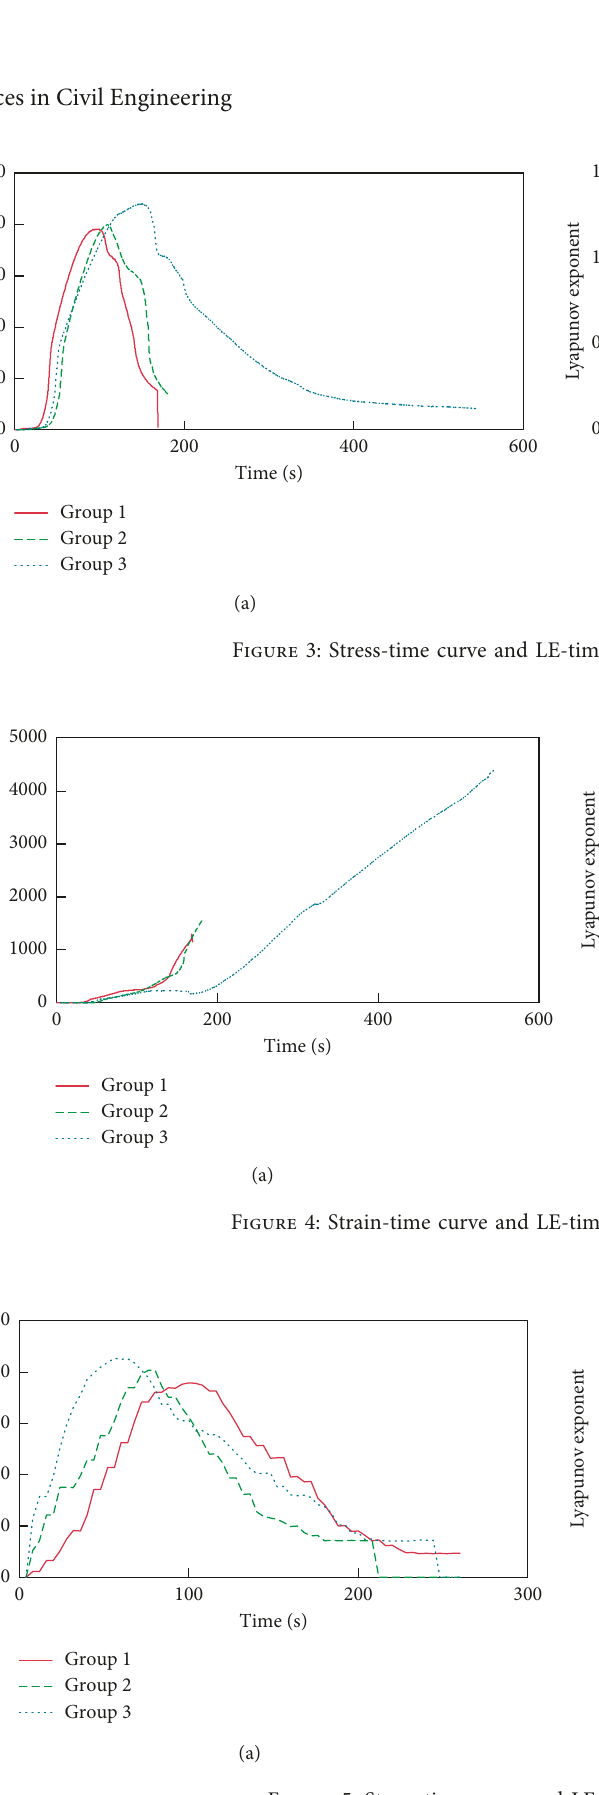
Figure 5: Stress-time curve and LE-time curve of fitted